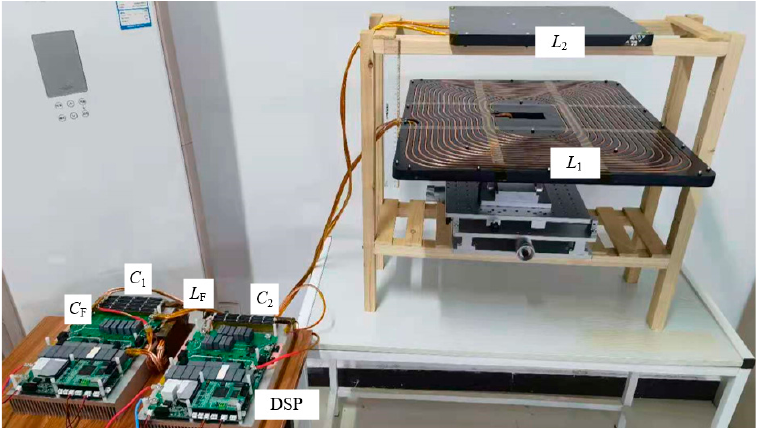
Figure 7. Photo of the prototype. L 1 : Transmitter coil; L 2 : Receiver coil; C 1 , C F : Resonant capacitors on the transmitter side; L F : Resonant inductor on the transmitter side; C 2 : Resonant capacitor on the receiver side; DSP: digital signal processor TMS320F28335.